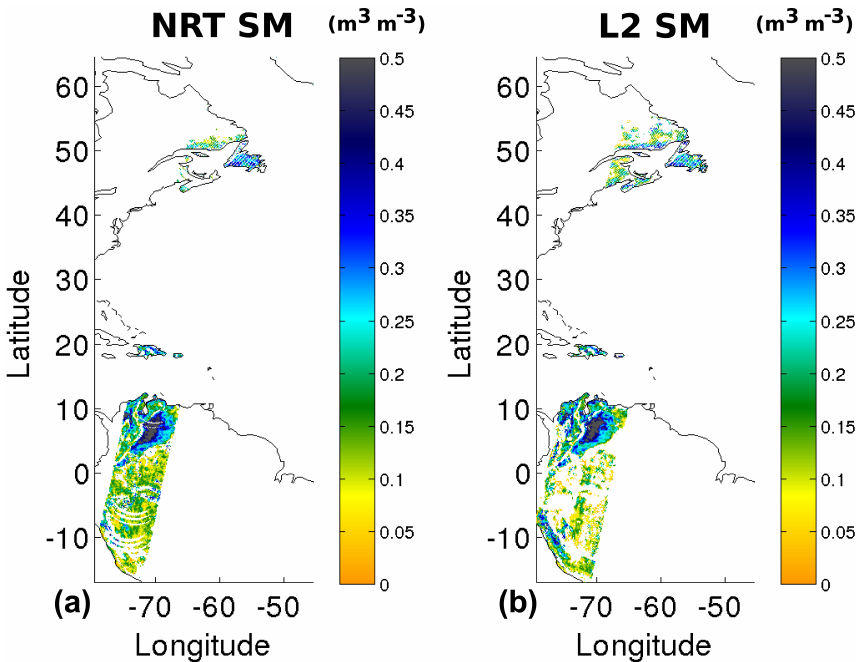
Figure 2. Comparison of the NRT SM NN product (a) and the Level 2 SM (b) for one orbit of 27 May 2012.